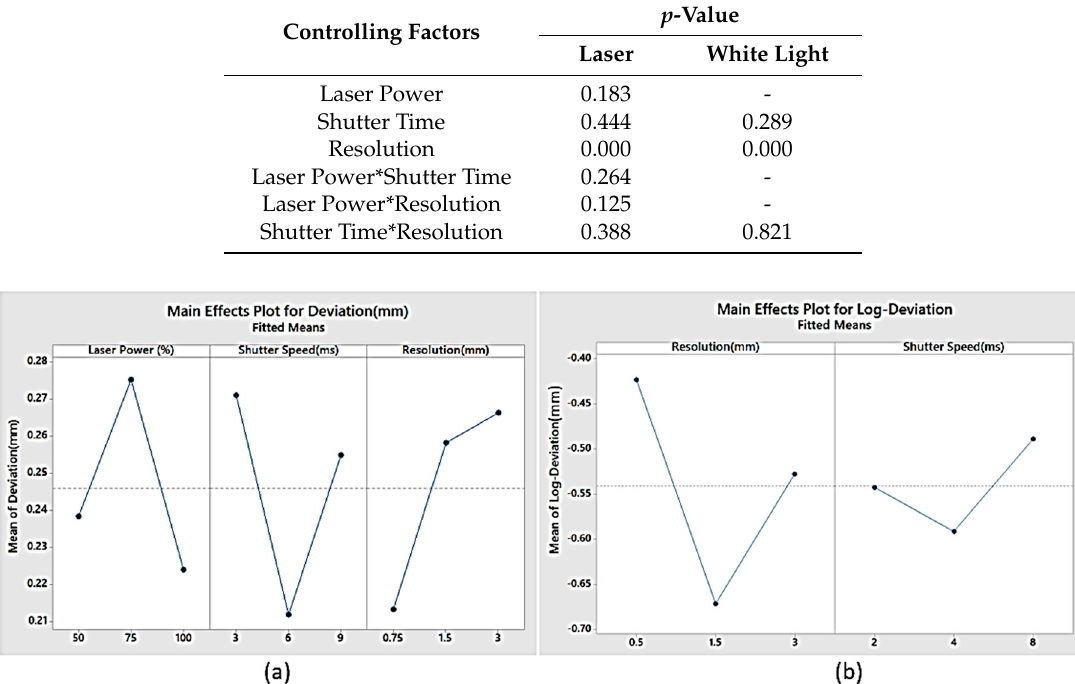
Figure 14. Main effect plots for deviation: ( a ) laser scanner; ( b ) white light scanner.